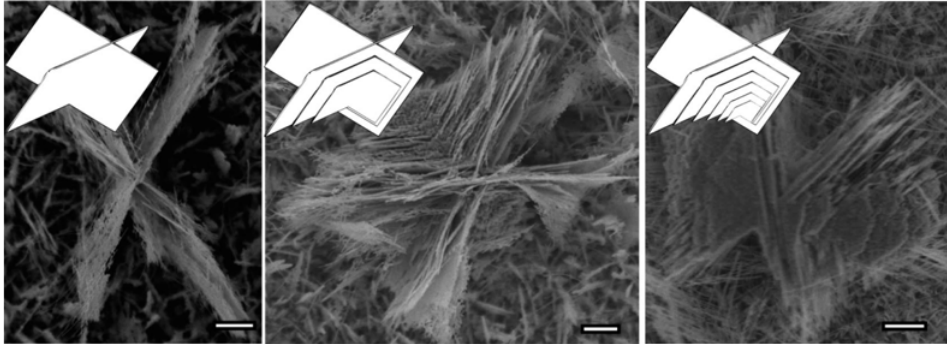
Figure 6. The progression of the TiSi complex nanostructures during a growth is revealed 2 in this SEM image series. Scale bars: 1 μ m [25]. Reproduced with permissions from American Chemical Society